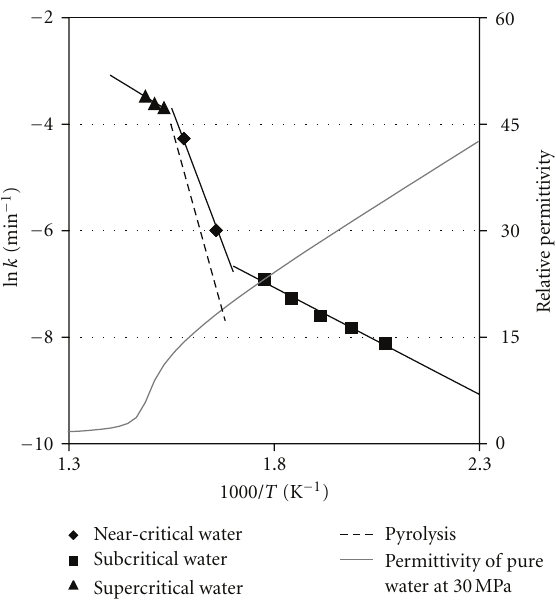
Table 5: Apparent Arrhenius parameters of a first order degra- dation of guaiacol by pyrolysis and hydrothermal treatment in subcritical, near critical and supercritical water.